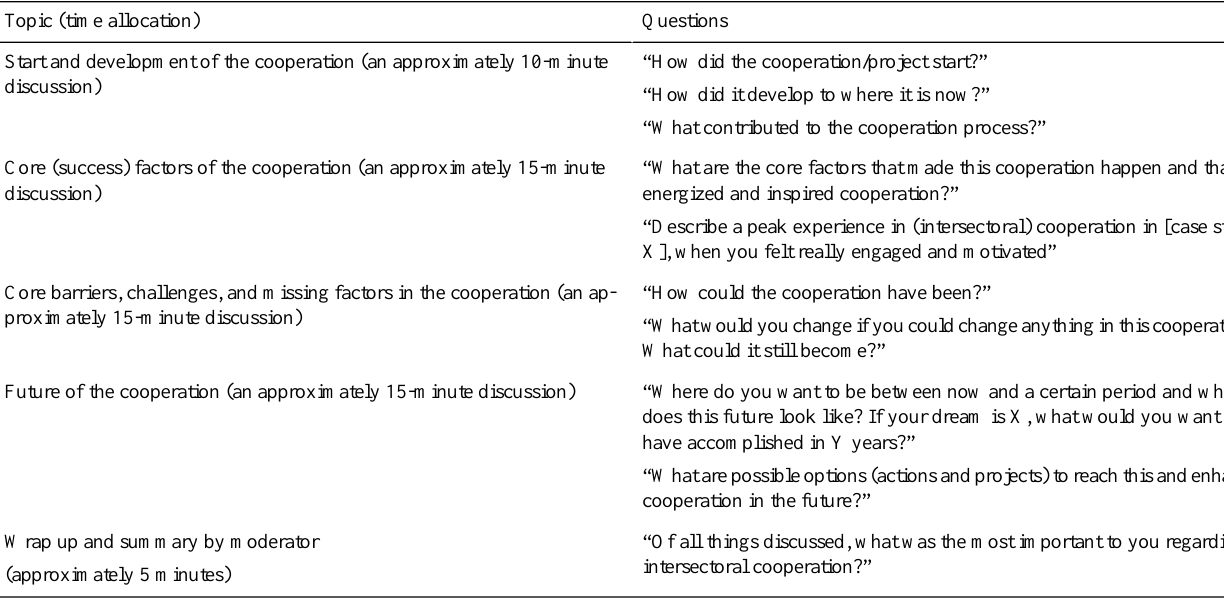
Table 1. Overview of focus group topics and questions. QuestionsTopic (time